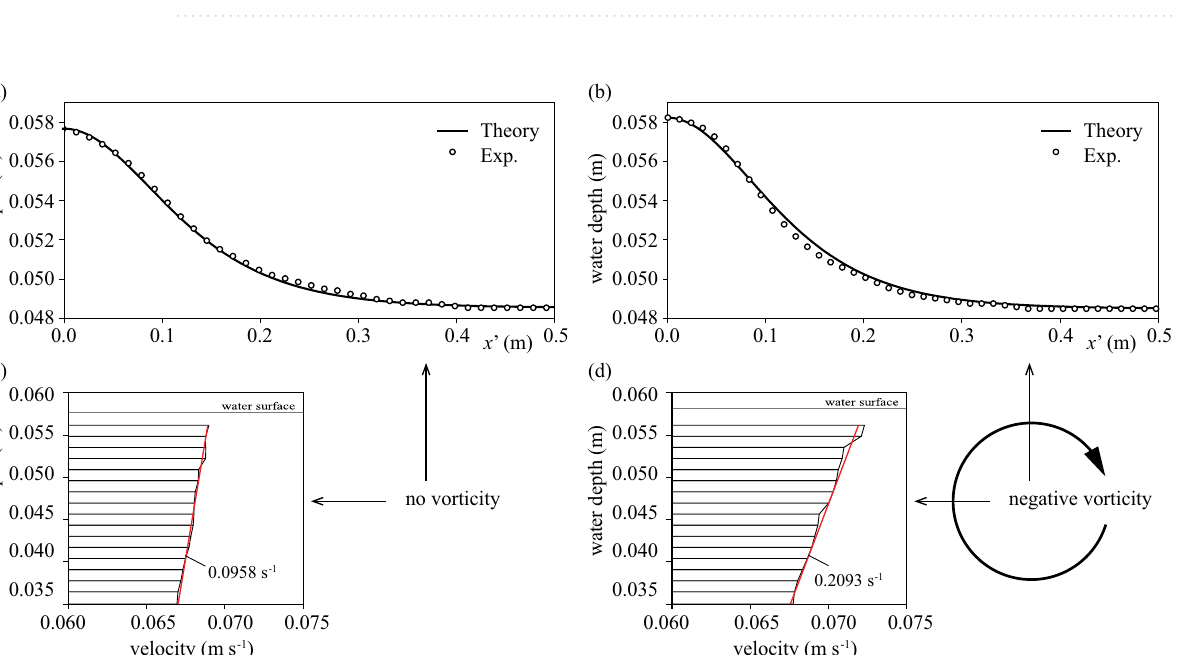
friction from the bottom and lateral walls was expected to reduce the wave celerity. The wave celerity of Lab2 was 0.59 m s −1 , smaller than that of Lab1 due to the additional bottom friction. The wave shape of Lab1 agreed very well with that by Fenton’s solution 39 (Fig. 2a). In contrast, Fenton’s solution overestimated the wave shape of Lab2 in the trough area (Fig. 2b). It was demonstrated that Fenton’s solution agreed very well with the fully nonlinear and strongly dispersive surface wave 26 , suggesting that the surface wave of Lab1 was a typical solitary wave. Choi 11 demonstrated that the water depth in the trough area decreases by giving negative vorticity to the progressive solitary wave in the positive direction, which agreed with our laboratory experiments. The influence of vorticity on solitary waves was evaluated using the Froude number ( F V ) defined by Choi 11 as the ratio of vorticity × water depth and wave celerity. The vertical profile of horizontal velocities obtained